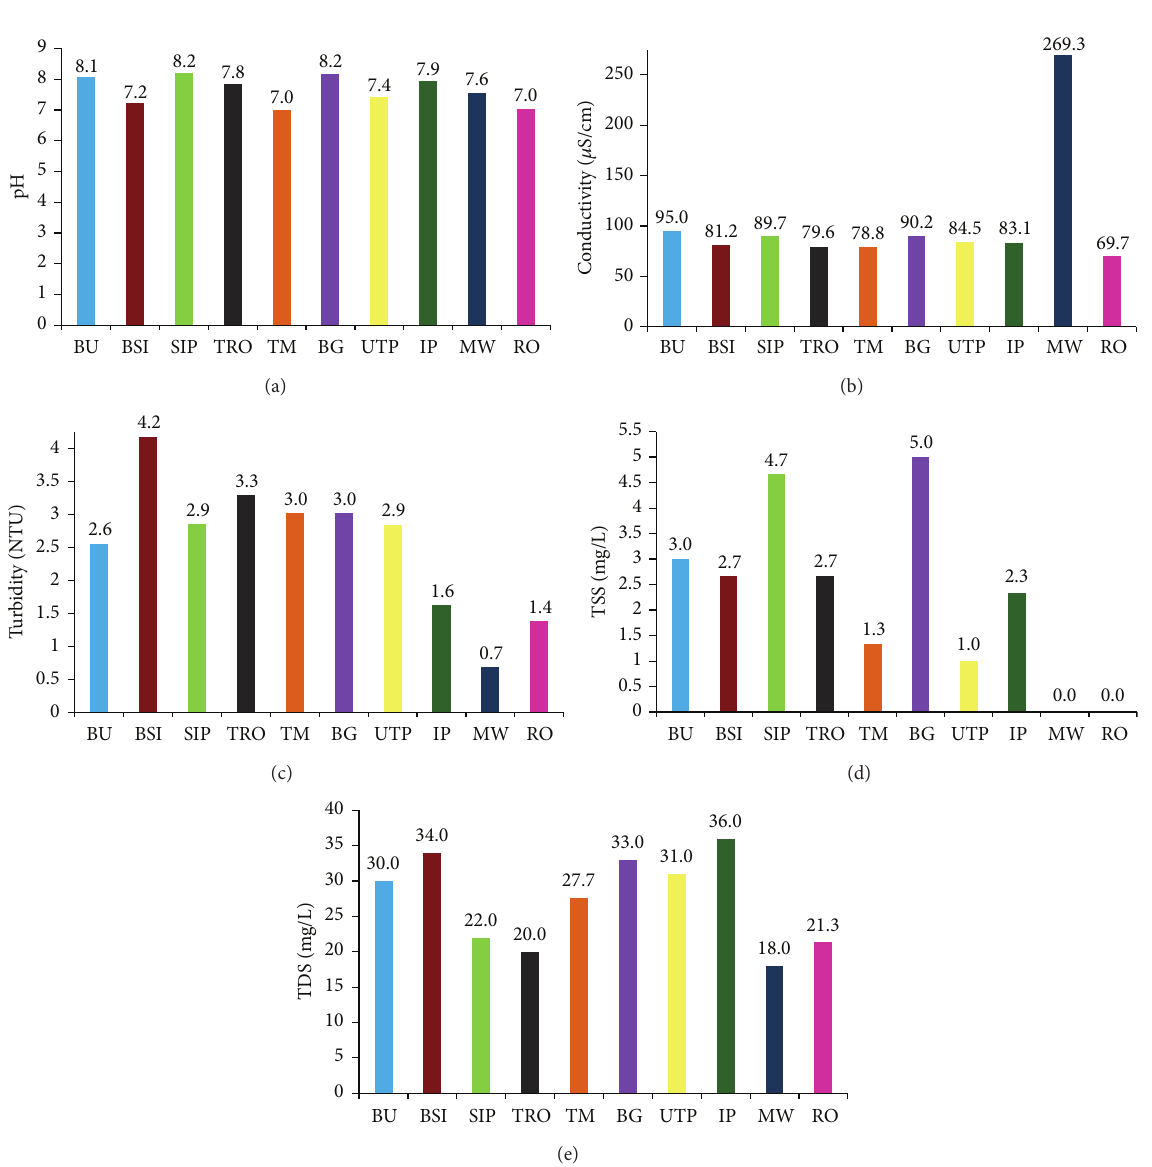
Figure 2: Various physical-chemical parameter analysis of drinking water samples in Perak state, Malaysia. (a) pH, (b) conductivity, (c) turbidity, (d) TSS, and (e)